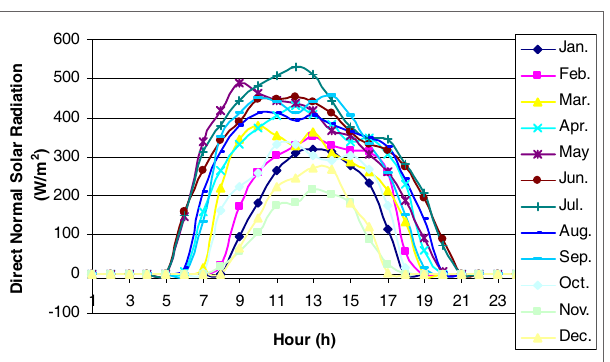
FigUre 8 | Direct normal solar radiation for case study